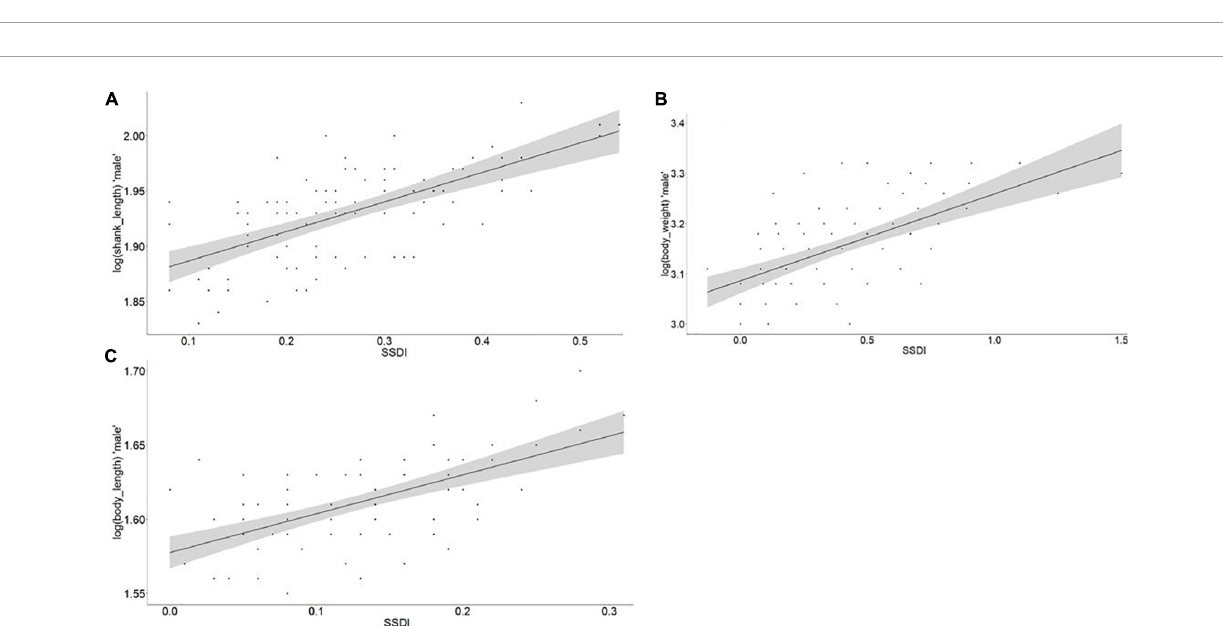
FIGURE8 Test of Rensch’s rule for the morphology. The regression was run log (male morphological trait) as dependent variable and SSDI value (Lovich and Gibbons, 1992) was calculated with the following formula ([Male/Female] – 1) as independent variable; (A) shank length, R 2 = 0.43, slope = 1.59, P -value = 0.0001; (B) body weight, R 2 = 0.37, slope = 2.15, P -value = 0.0001; (C) body length, R 2 = 0.36, slope = 1.38, P -value =